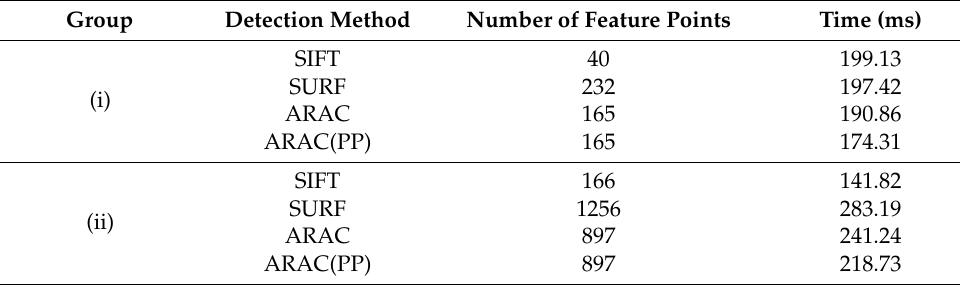
Table 1. Feature extraction time of three spot detection